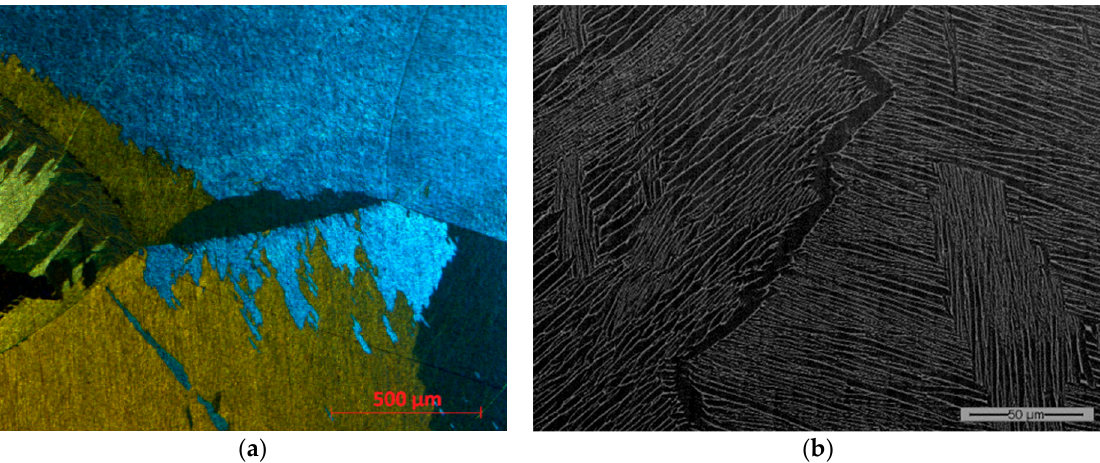
Figure 7. Lamellar microstructure obtained with annealing temperature T β + 75 ◦ C for 1 h 30 min, viewed with polarized optical microscopy ( a ) and SEM ( b